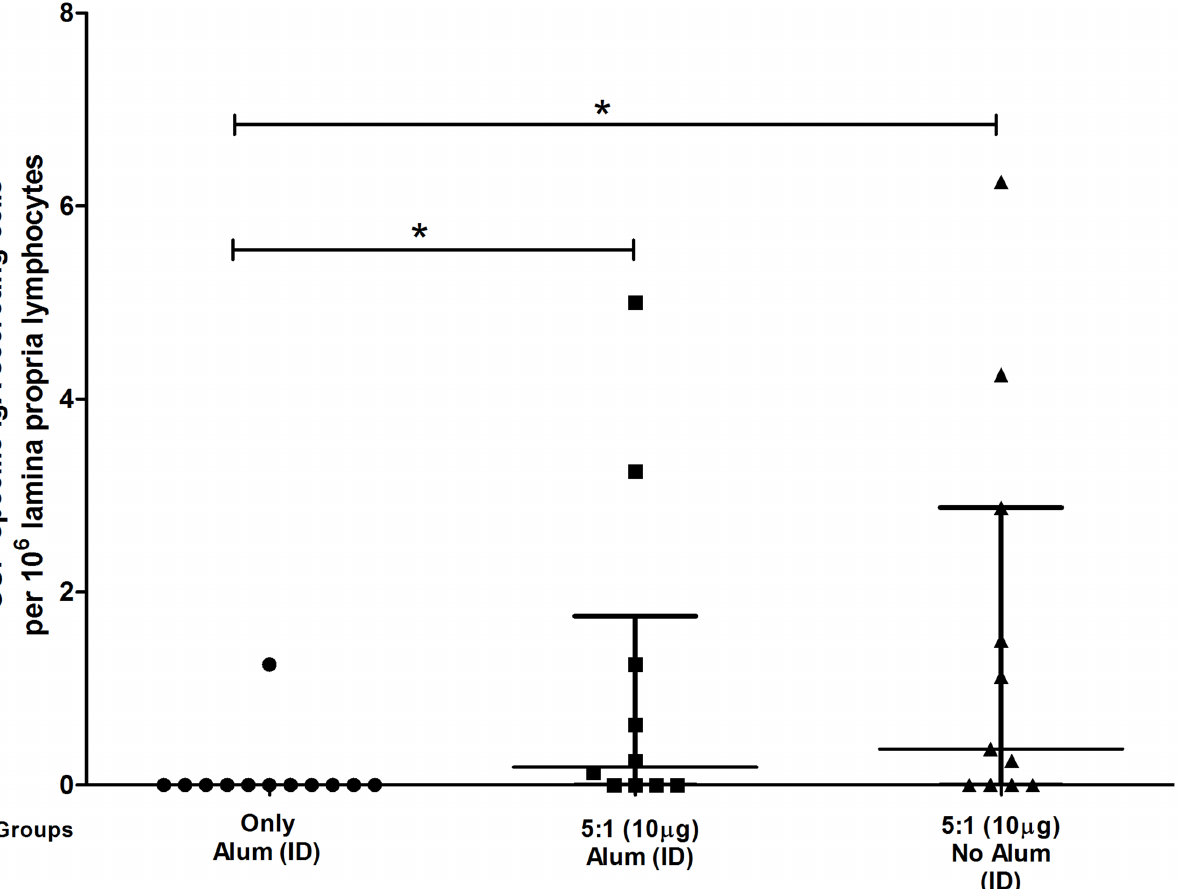
Fig 7. OSP-specific IgA secreting cells in intestinal lamina proprial tissue following intradermal immunization. An asterisk denotes a statistically significant difference ( P < 0.05) in mean from the group immunized with alum only.